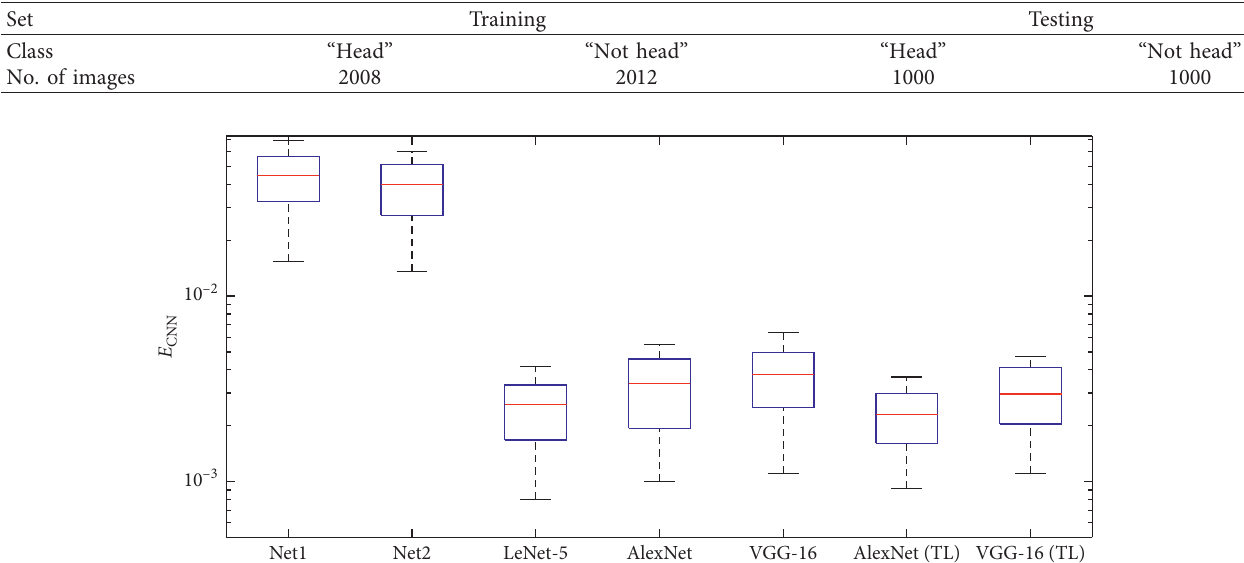
Figure 10: Boxplot representation of loss function values ( y -axis) obtained by validation of ConvNet-based passenger recognition systems. Architectures of the ConvNets and training strategy are at x -axis (TL � transfer learning, otherwise, the network was trained from